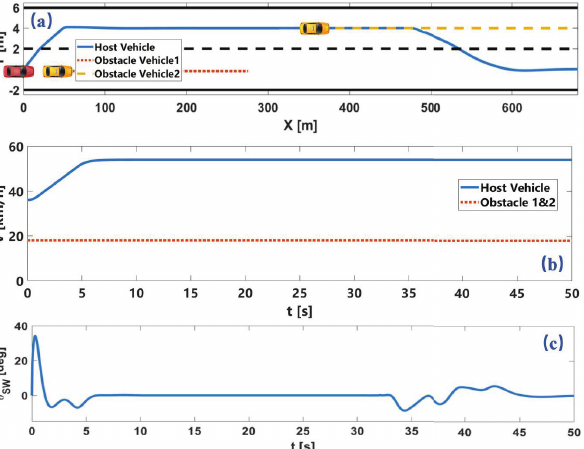
Figure 8. Simulation results of obstacle avoidance on a straight lane. Here, ( a ) is vehicle trajectory. ( b ) is vehicle velocity. ( c ) is steering wheel angle.